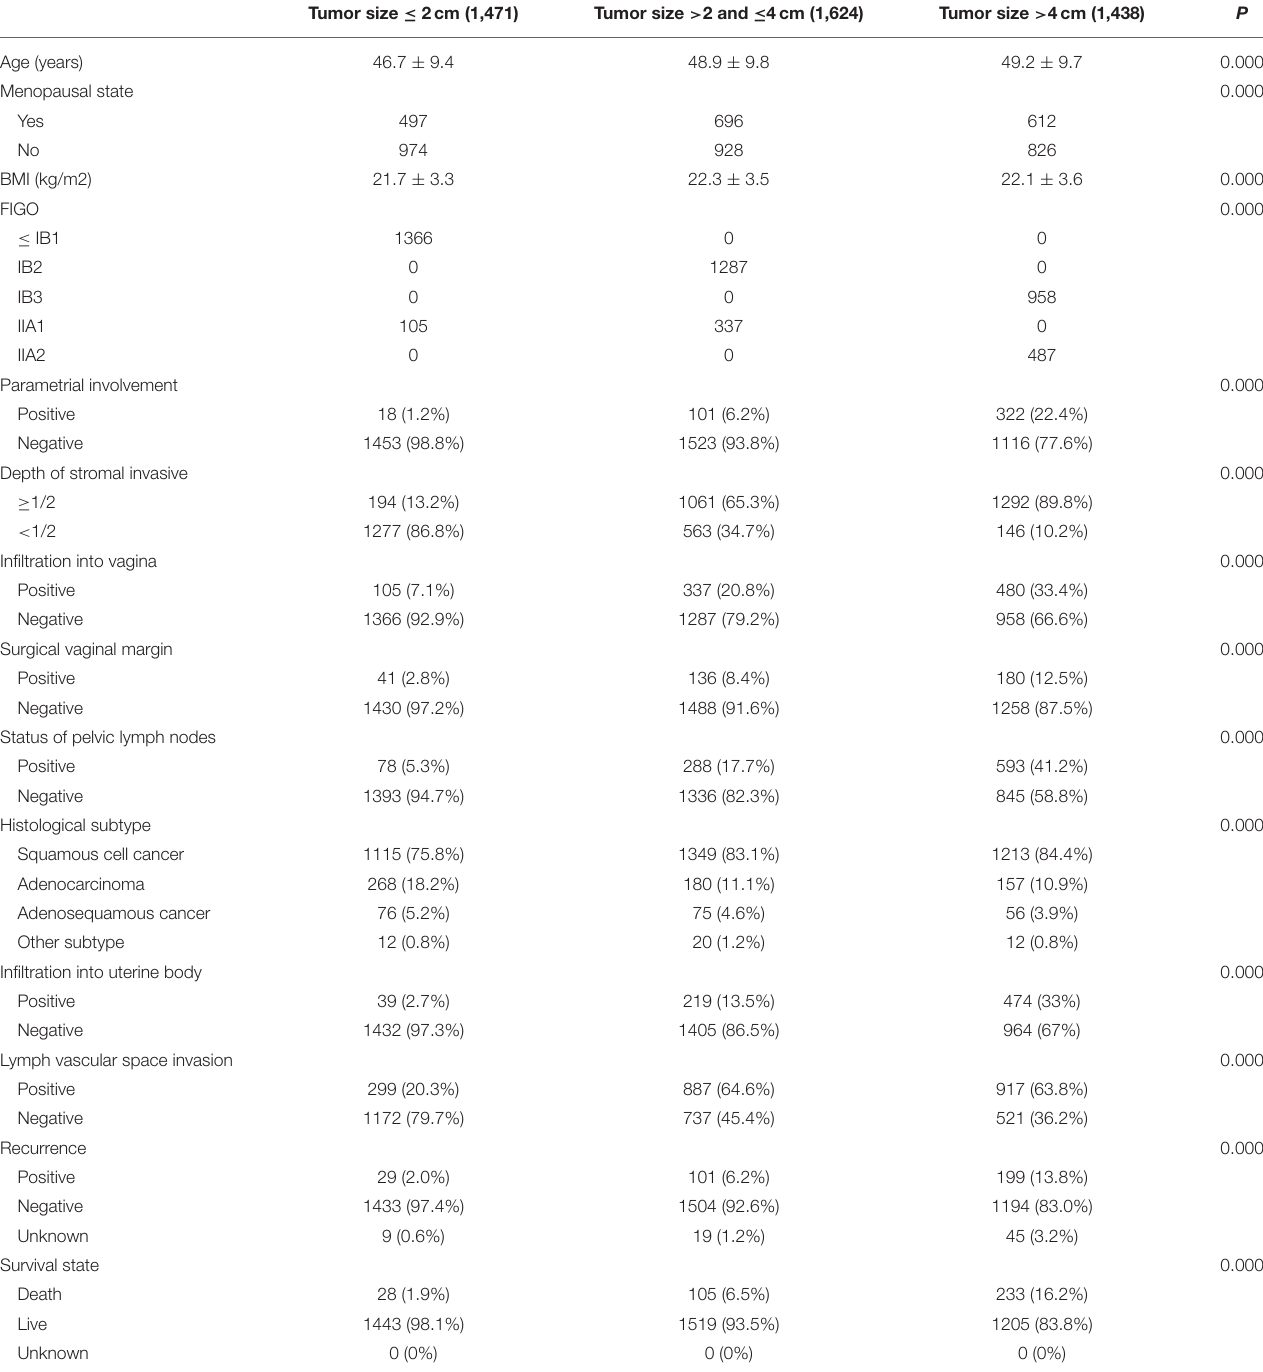
TABLE 1 | Clinical and pathological characteristics of the patients related to the size of the